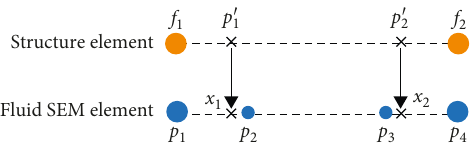
Figure 2: Consistent mapping